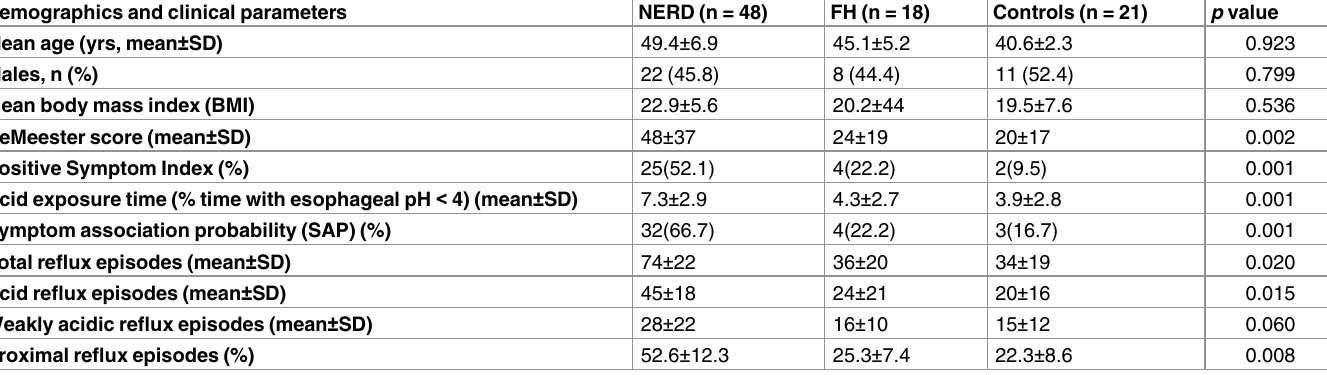
Table 1. Demographics and clinical characteristics of patients with non-erosive reflux disease (NERD) were classified based on acid exposure time (AET) and symptom association probability (SAP).